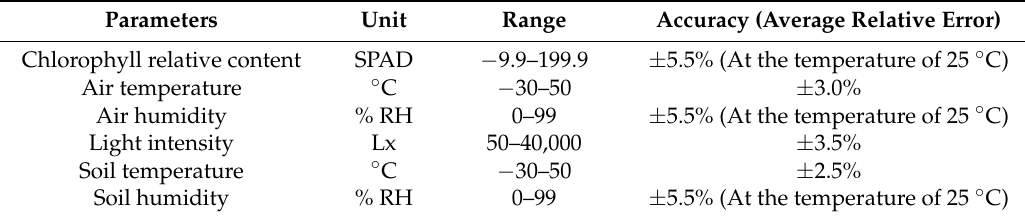
Table 1. The basic requirements for the measurement parameters.